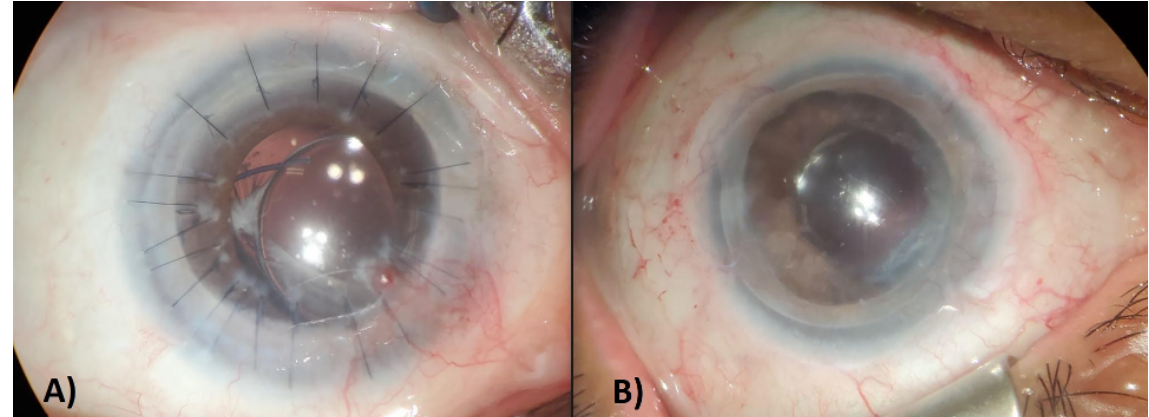
Figure 2: Post-surgical photograph of the (A) right cornea and limbus 2 years after keratolimbal allograft (KLAL) and 1.5 years after penetrating keratoplasty (PKP); and the (B) left cornea and limbus 5 years after PKP and 3 years after KLAL. The PKP graft remained clear in both